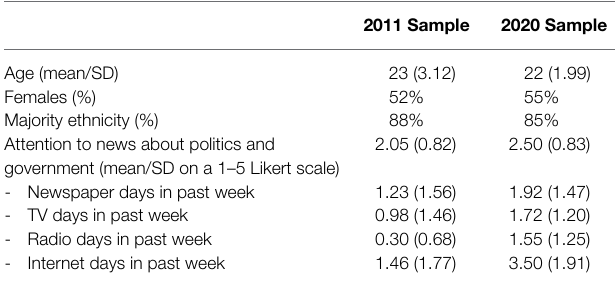
TABLE 1 | Basic statistics about the 2011 vs. 2020